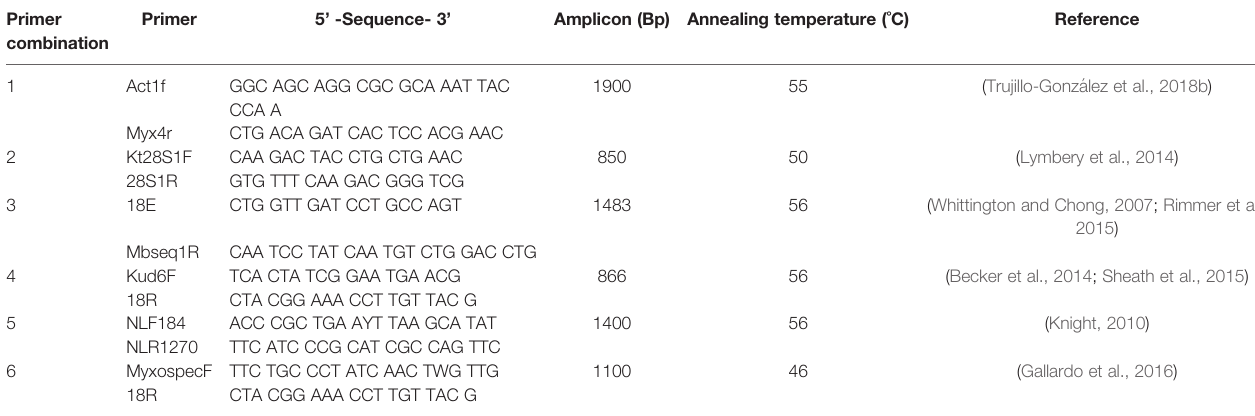
TABLE 1 | Primers for myxozoa ribosomal